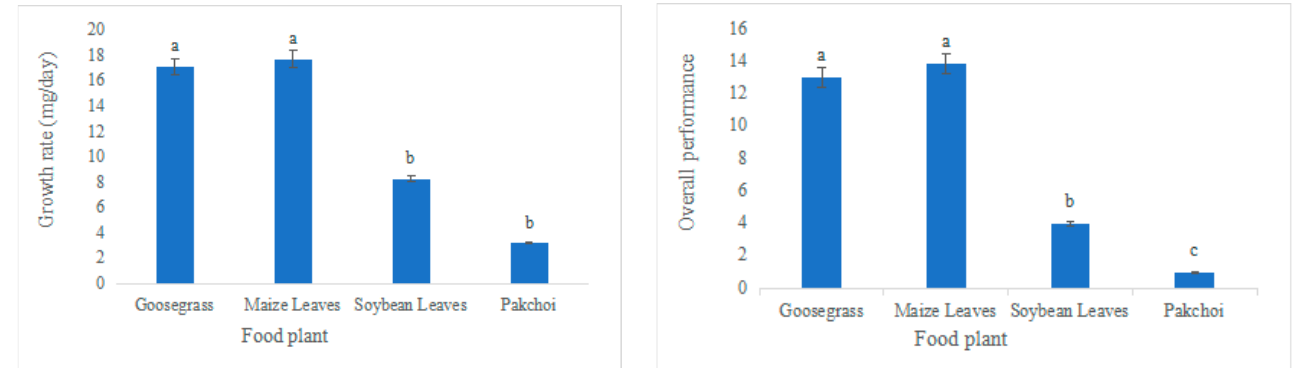
Figure 1. Food utilization efficiency by Locusta migratoria manilensis (Meyen) reared on four food plants. AD, ECI, and ECD indicated approximate digestibility (means ± SE), efficiency of conversion of ingested food (mean ± SE) and efficiency of conversion of digested food (mean ± SE), respectively. Significant differences within AD, ECl, and ECD are indicated by lowercase letters (ANOVA, p < 0.05), respectively.